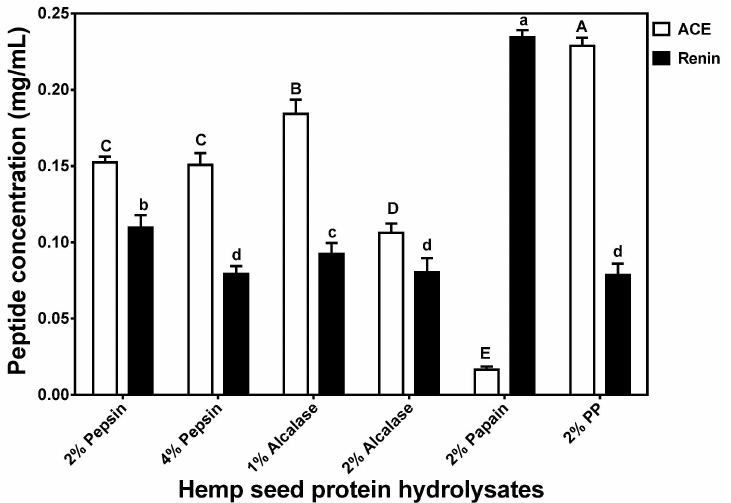
Figure 5. Peptide concentrations that inhibited 50% activity (IC converting enzyme